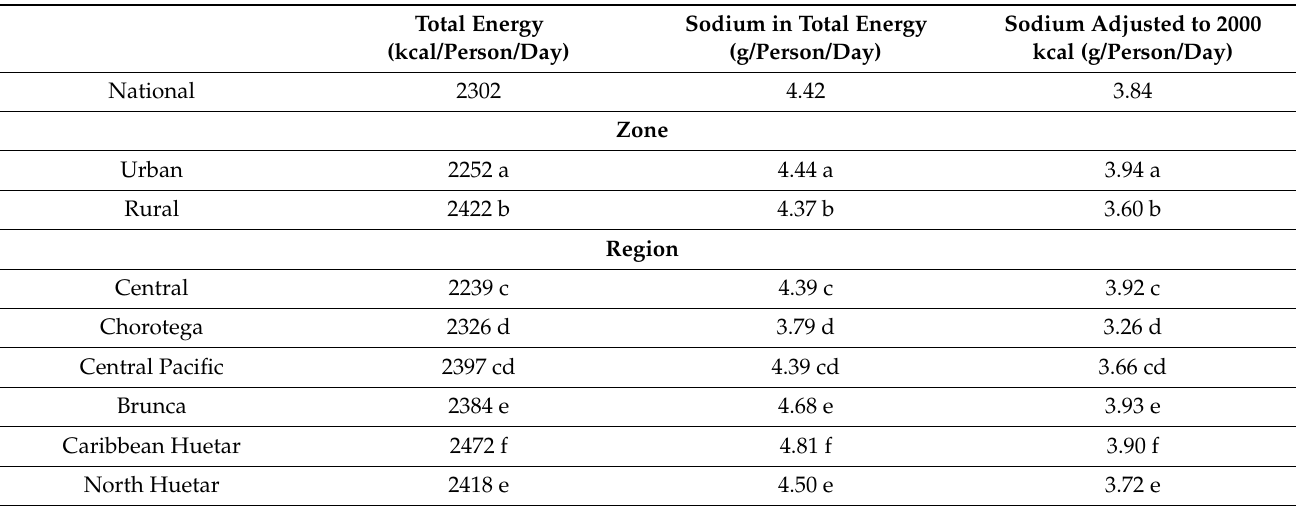
Table 1. Energy and sodium availability for household consumption at the national level, by zones and planning regions in Costa Rica, 2018–2019.